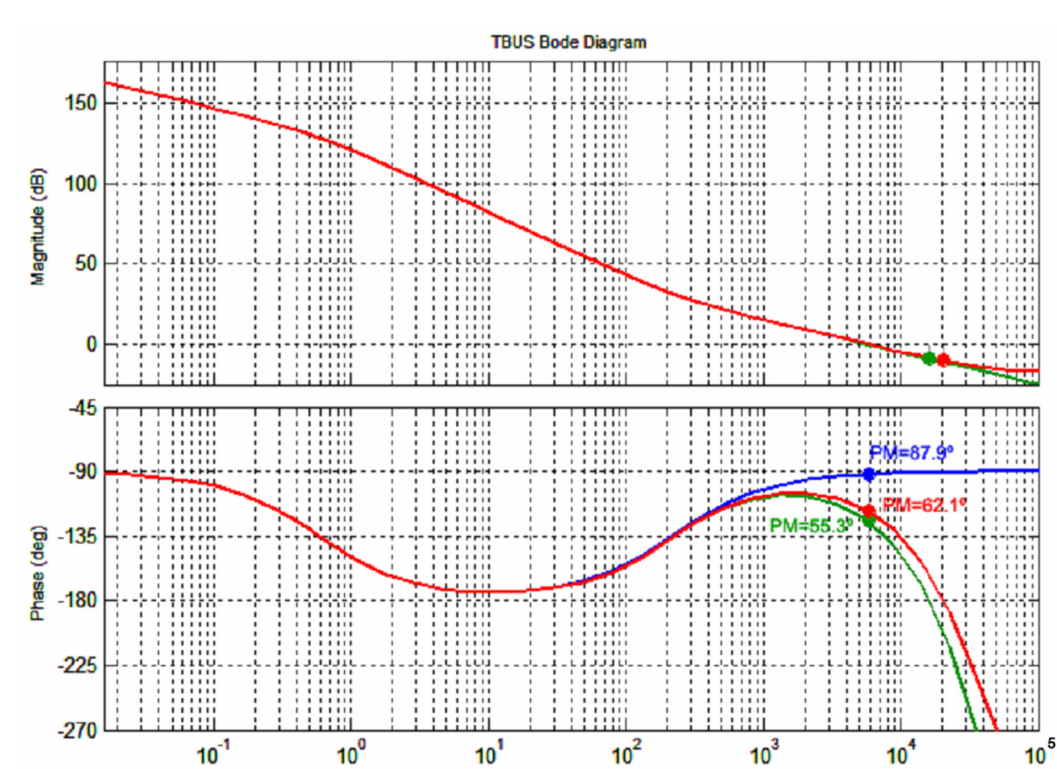
Figure 8. Simulated control loop response: blue, no delay; green, Csa delay; red, Csa delay + lead–lag